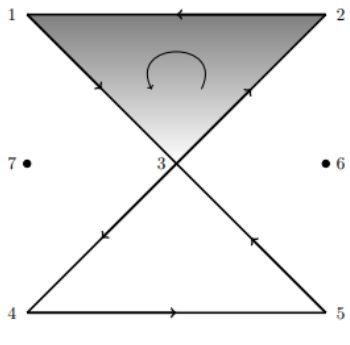
Figure 11. Simplicial